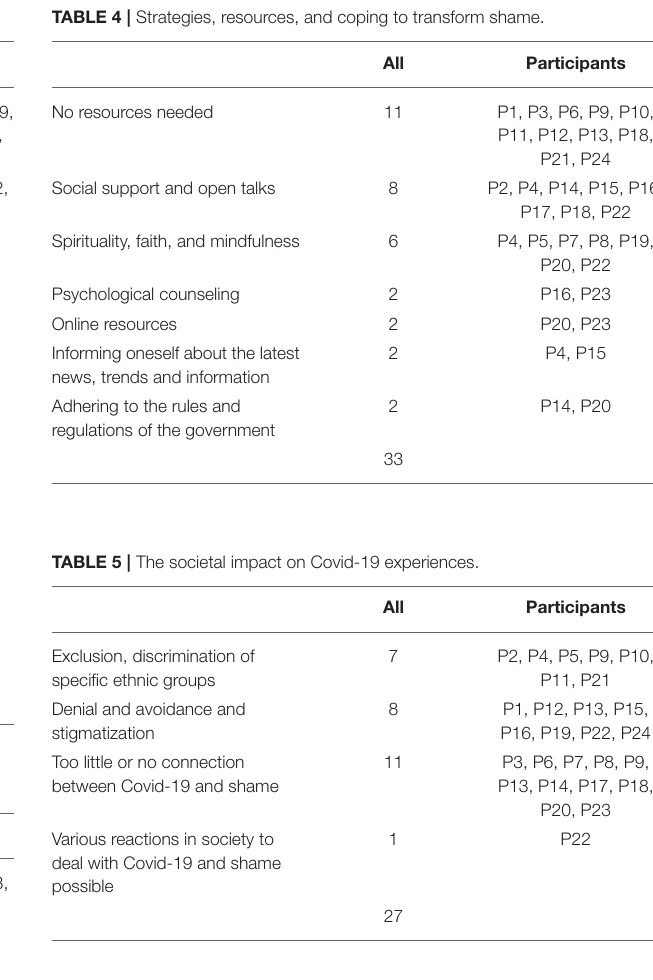
TABLE 4 | Strategies, resources, and coping to transform shame.